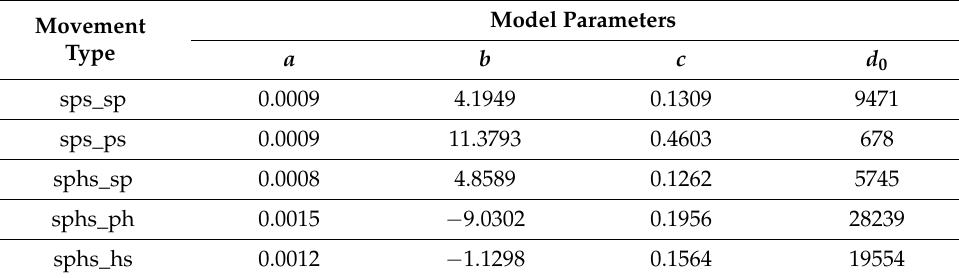
Table 3. Parameter values of the travel time models given by Equation (6) fitted on the Falck dataset.